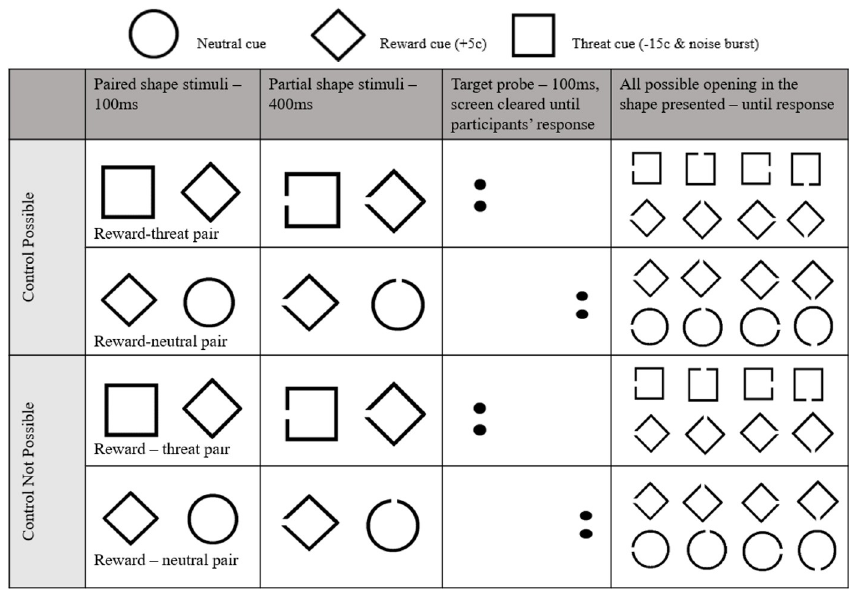
Fig 2. Example trials from the Attentional Bias Alignment Assessment